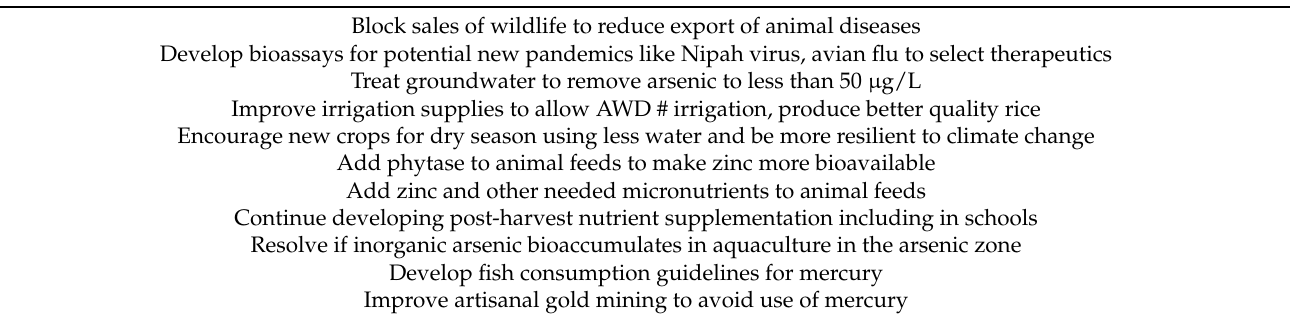
Table 3. Suggested actions for better disease